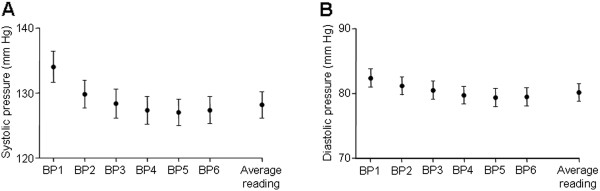
Comparison between first BpTRU reading and average BpTRU reading. A. Combined data for all patients, showing mean individual and average BpTRU systolic readings. ANOVA (repeated measures) showed a significant difference (P < 0.0001). Bonferroni’s multiple comparison post hoc test showed that the mean first BpTRU systolic measurement (± SD) (133.8 ± 22.5 mmHg) was significantly higher than the final average BpTRU systolic measurement (127.9 ± 19.0 mmHg; n = 91; P < 0.001). B. Combined data showing mean individual and average BpTRU diastolic readings. ANOVA (repeated measures) showed a significant difference (P < 0.0001); the subsequent Bonferroni’s post hoc test showed that the mean first BpTRU diastolic reading (81.2 ± 13.3 mmHg) was significantly higher than the final average BpTRU diastolic reading (80.2 ± 13.0 mmHg; n = 91; P < 0.001).